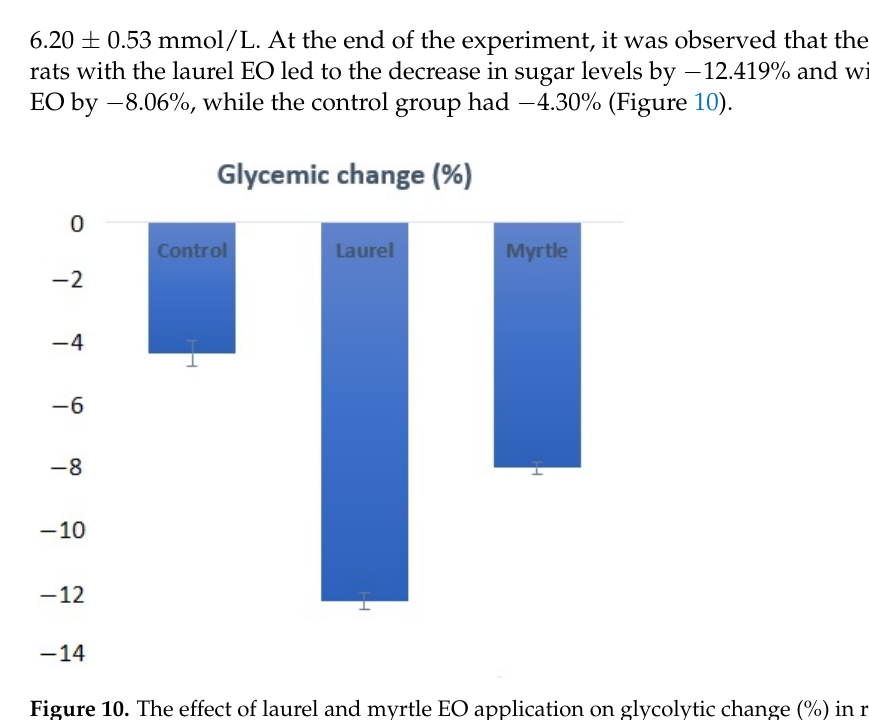
Table 5. Effect of laurel and myrtle EO application on the serum lipid biochemical parameters, ath- erogenicity and atherogenic risk predictor indices in rats.